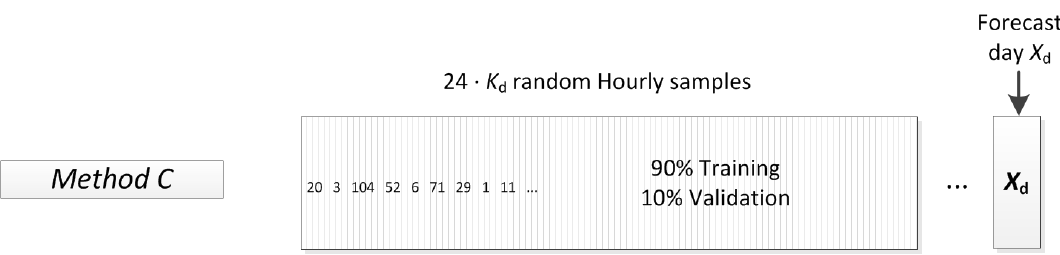
Figure 6. Hourly samples belonging to an extended period of time in a complete training database are randomly mixed. Table 1. Different methods for the composition of the ANN training data-sets which have